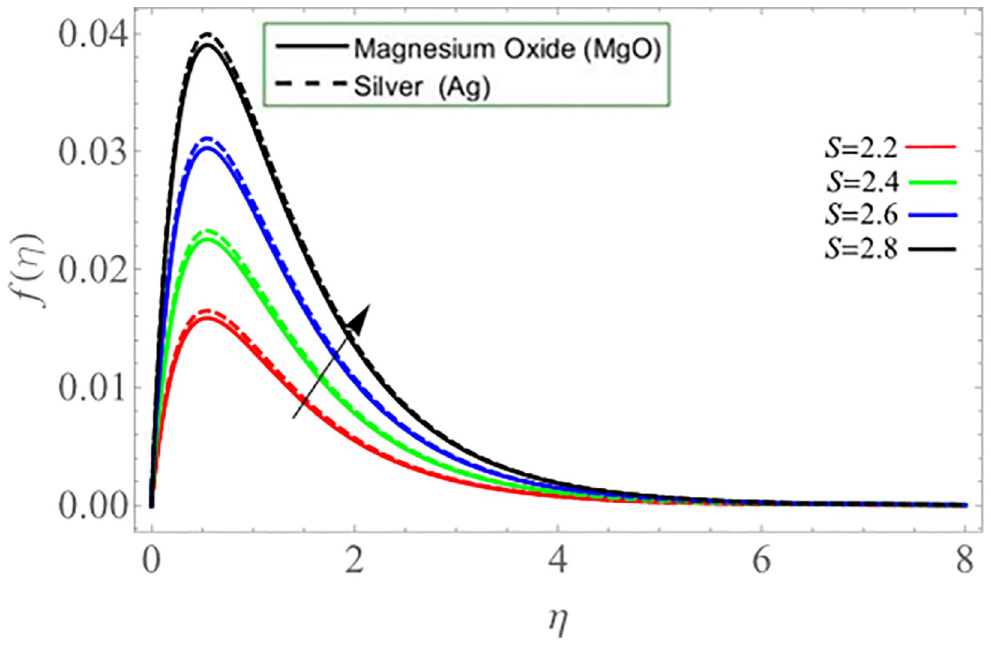
fluid thermal capability declines. Figs 11 & 12 demonstrate the influence of Batchlor number Bt on magnetic strength profile along axial m ’( η ) and radial direction n ( η ), respectively. The magnetic strength profile show declination versus the influence of Batchlor number, because the increment in Bt negatively affect the molecular diffusion rate of fluid.